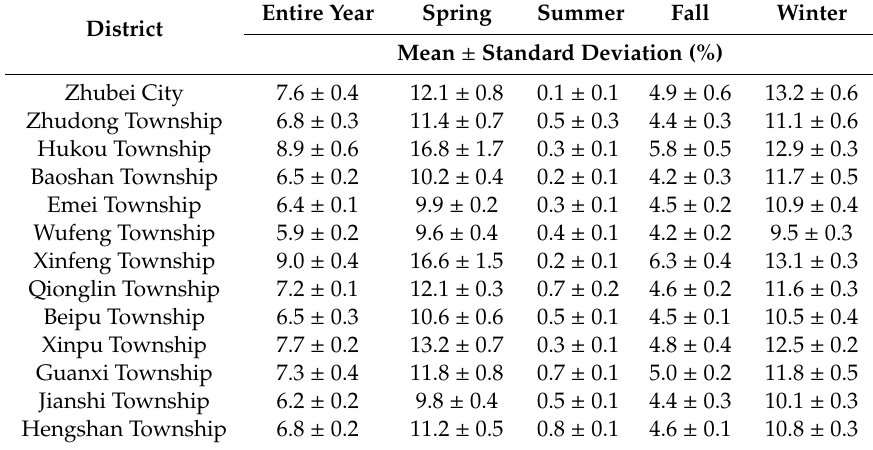
Figure 4. Boxplot of exceedance probabilities of 13 townships and cities in Hsinchu County. Table 2. Basic statistics of exceedance probabilities of 13 townships and cities in Hsinchu County.